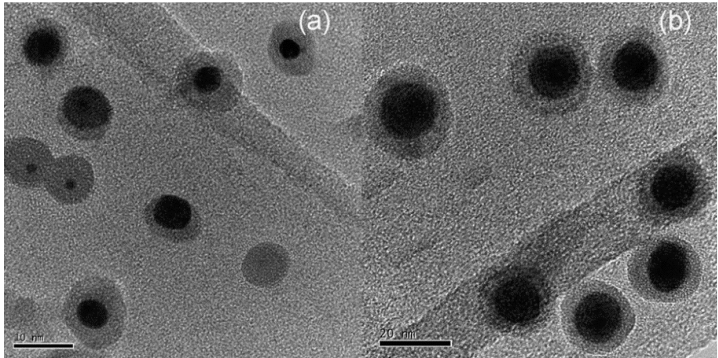
Figure 1. TEM micrographs of Ni-core Au-shell nanoparticles prepared in